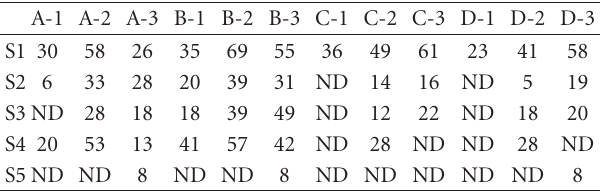
Table 1: Comparative toxin and toxoid sequence analysis (% amino acid